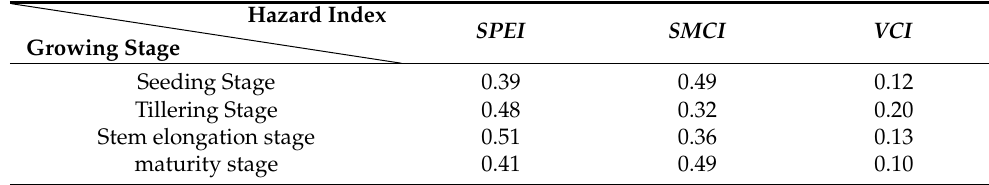
Table 3. Weight coefficients of the hazard indicators of the comprehensive drought index in the four growth stages of